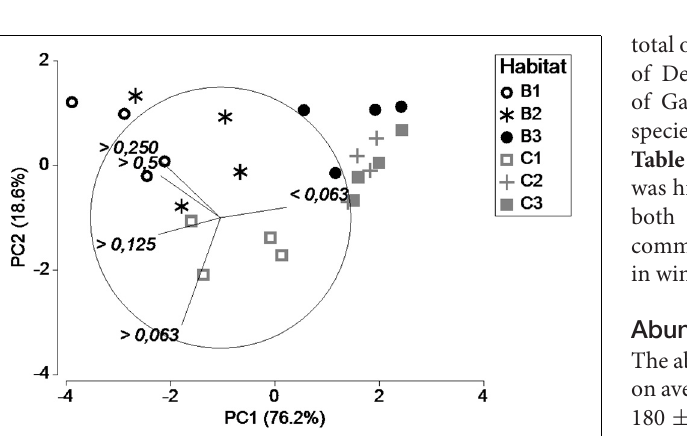
FIGURE 2 | Sediment total organic matter content (TOM%, average ± SD) per habitat and in the different habitats across seasons.